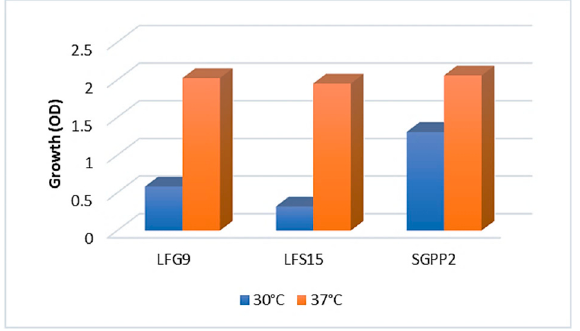
Figure 4. Growth of bacterial strains at 30 °C and 37 °C after 6 days. Bars represent the difference between the final and initial values of the optical densities (600 nm). LFG9: Shinella zoogloeoides ; LFS15: Bacillus swezeyi ; SGPP2: Pseudomonas guguanensis .